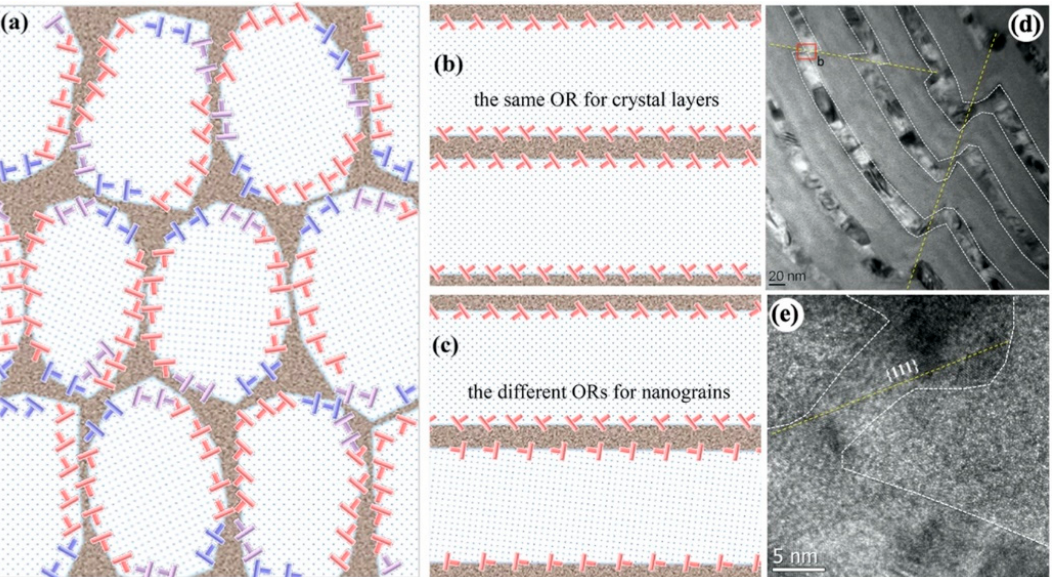
Figure 11. ( a ) A schematic of deformation mechanisms for core–shell nanostructures. Dislocations carried over plastic deformation in nanograins and are blocked at CAIs [53]. ( b ) Good slip continuity for two neighbouring nanograins. ( c ) Poor slip continuity for two neighbouring nanograins. ( d , e ) TEM images showing shear banding in Cu/CuZr nanolaminate due to slip continuity in Cu layers [70].